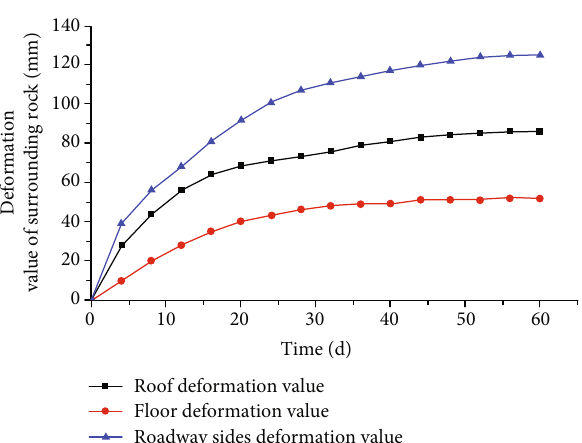
Figure 12: Vertical stress of two sides.